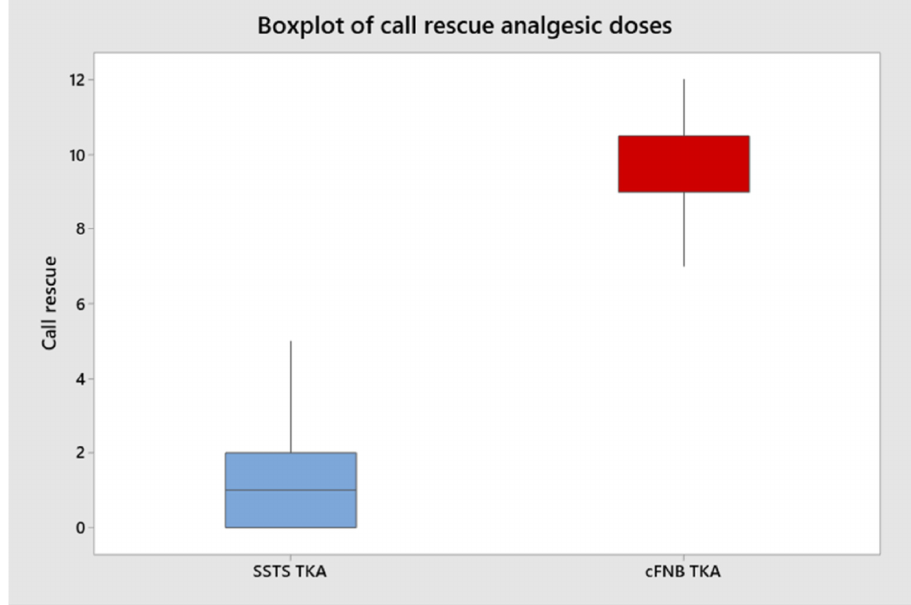
Figure 4. Boxplot analysis rescue doses between the two groups. Horizontal line represents mean value and the square box represents interquartile range.